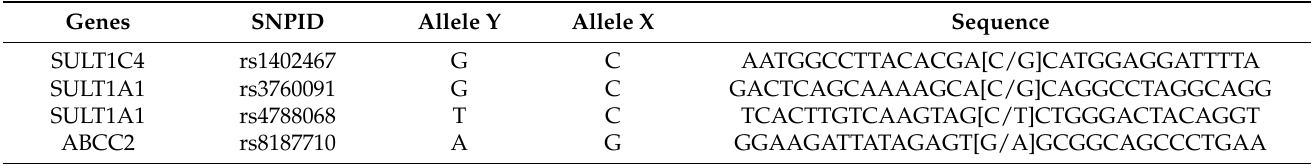
Table 1. Single Nucleotide Polymorphisms and primers